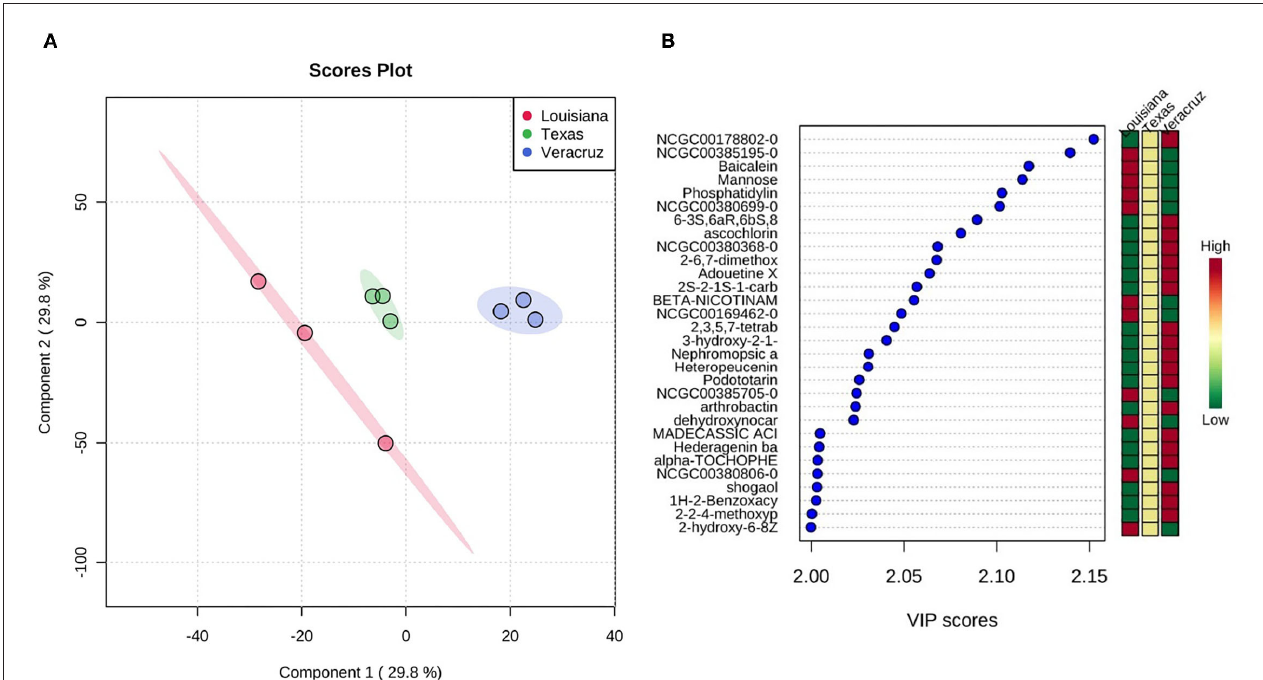
FIGURE 2 | (A) Scores plot between the selected principal components. The explained variances are shown in brackets. (B) Important features identified by PLS-DA. The colored boxes on the right indicate the relative concentrations of the corresponding metabolite in each group under study. TABLE 1 | Multivariate analysis results from the nutrient composition of sugarcane bagasse samples from three different locations. VER LA TX MANOVA % Lignin 13.8 ± 0.21 11.10 ± 0.75 9.20 ±